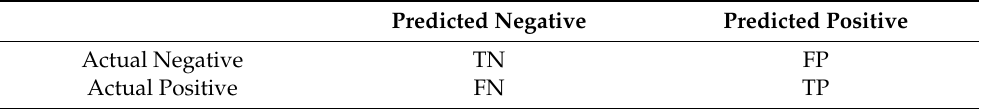
Table 2. The confusion matrix for binary